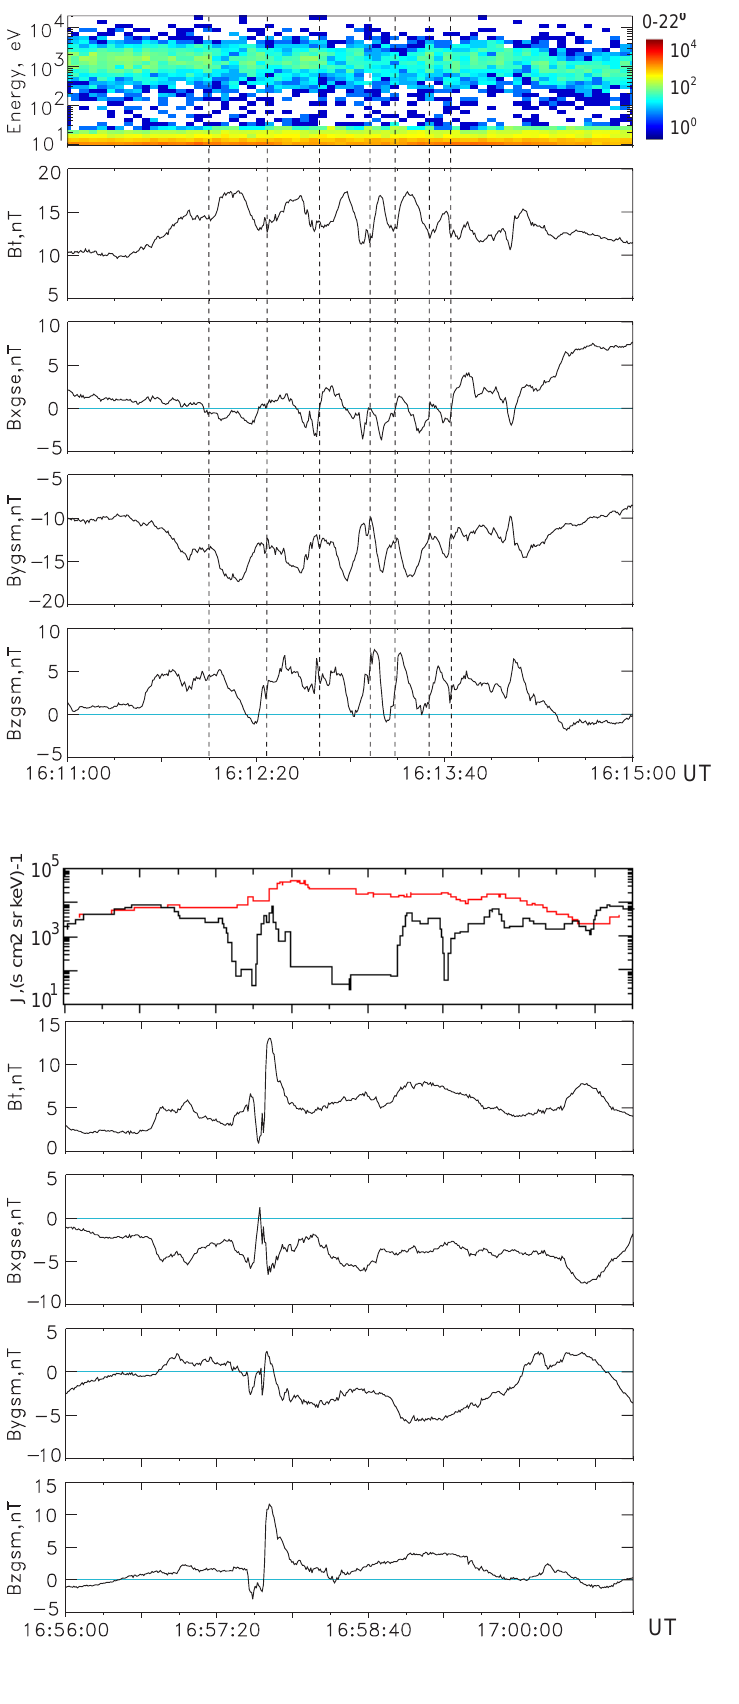
Fig. 3b. Energetic ions and magnetic field variations during the bursty bulk flow event detected between 16:56:00 and 17:00:40UT (event A in Fig. 2). From top to bottom: ion fluxes in the energy range 21–28keV (the red curve is for ions streaming tailward, the black one for ions streaming approximately earthward), magnetic field magnitude and